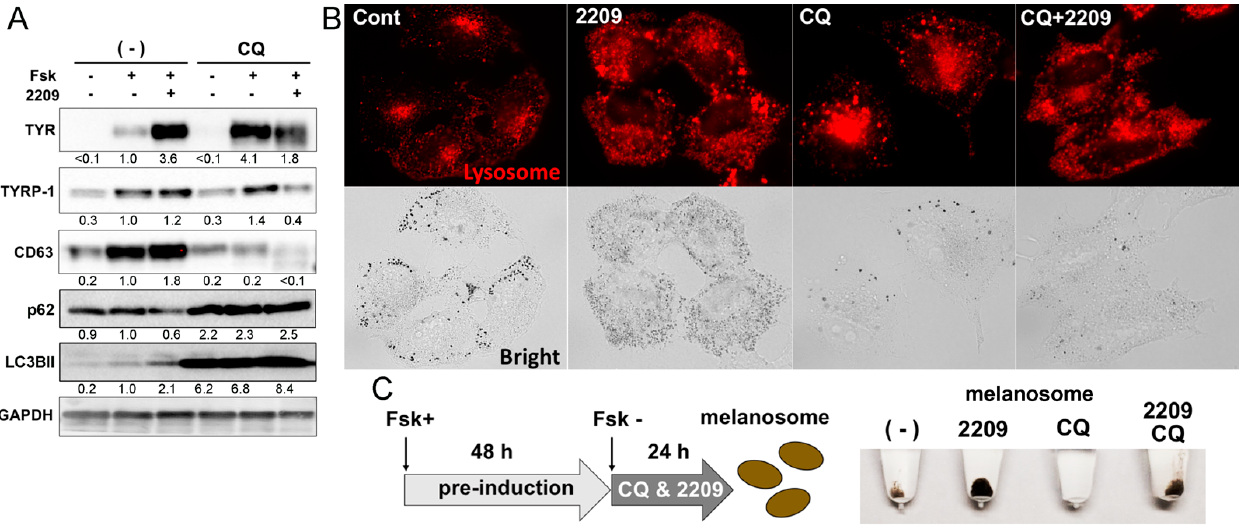
Figure 6 . ( A ) B16F10 cells were treated with GIF-2209 (3 μ M) and chloroquine (10 μ M) in the presence of Fsk (20 μ M) for 24 h. The cells were harvested for western blot analysis. The images are representative of triplicate experiments. Signal intensity was normalized to that of GAPDH. ( B ) The lysosomes in cells that had been treated as in ( A ) were stained with Cell Navigator ® Lysosome Red. ( C ) Melanogenesis in B16F10 cells was induced by treatment with Fsk (20 μ M) for 48 h. Then, the cells were cultured with fresh media containing GIF-2209 (3 μ M) and chloroquine (10 μ M) for 24 h for melanosome recovery. Signal intensity of each protein was normalized to that of GAPDH.